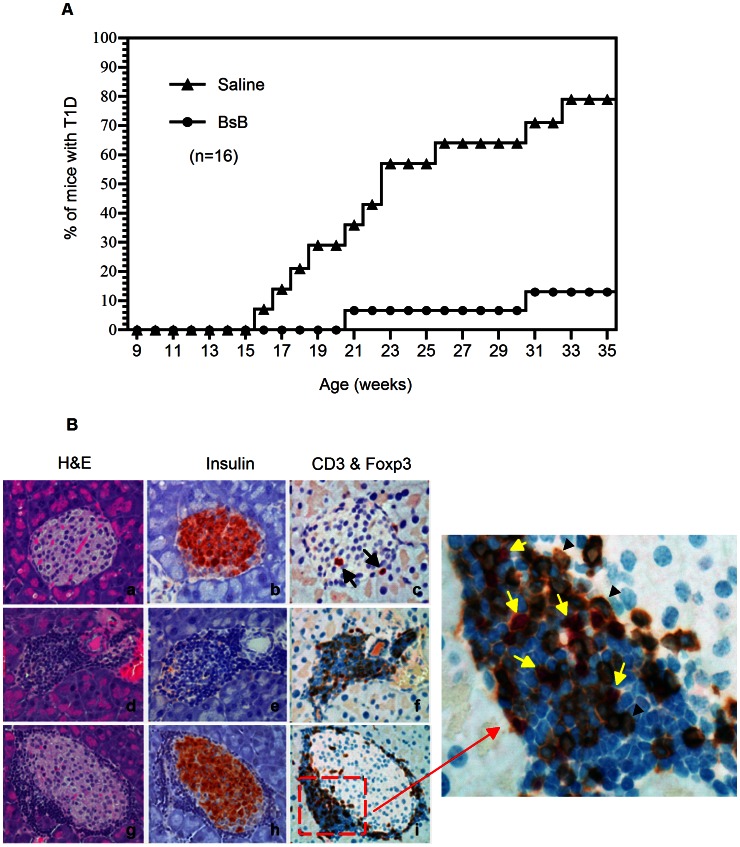
Longer-term treatment of NOD mice with BsB significantly delayed the onset of T1D in NOD mice.(A) The cumulative incidences of overt diabetes in BsB-treated (n = 16) and untreated mice (n = 16). BsB treatment significantly reduced the incidence of T1D compared with mice treated with saline (p<0.01). (B) A histopathological analysis of pancreatic tissues from animals treated with saline or BsB. Panels a through c represent the sections from saline-treated mice that remained non-diabetic with H&E, an antibody to insulin (pink), or anti-CD3 (brown) and Foxp3 (pink), respectively. Similar observations were noted in BsB-treated NOD mice that remained disease-free. No evidence of infiltration or insulitis was noted in any of the sections; a few Foxp3+ Tregs may be present (arrows in panel c). Panels d through f represent the pancreatic sections from diabetic NOD animals. Invasive insulitis was clearly evident, and the insulin-producing β-cells were completely destroyed (e). Several CD3+ T cell infiltrations were also detected along with a few Tregs and many non-T cell leukocytes with blue nuclei (f). Panels g through i show that the islets of BsB treated animals that remained non-diabetic but exhibited characteristic peri-insulitis. Leukocyte infiltrations were noted but were restricted to the periphery of the islets. Moreover, there was no notable destruction of the insulin-producing β-cells. Most of the leukocytes at the periphery were non-T cells (with blue nuclei). The enlarged inset (panel j, represents the red square in i) indicated Foxp3+ Tregs (yellow arrow head) were intermixed with other CD3+ T cells and non-T cell leukocytes (with blue nuclei) at the periphery of islets. The images were acquired with a 40× objective; the inset was acquired with a 60× objective, which was then further enlarged 3× digitally.